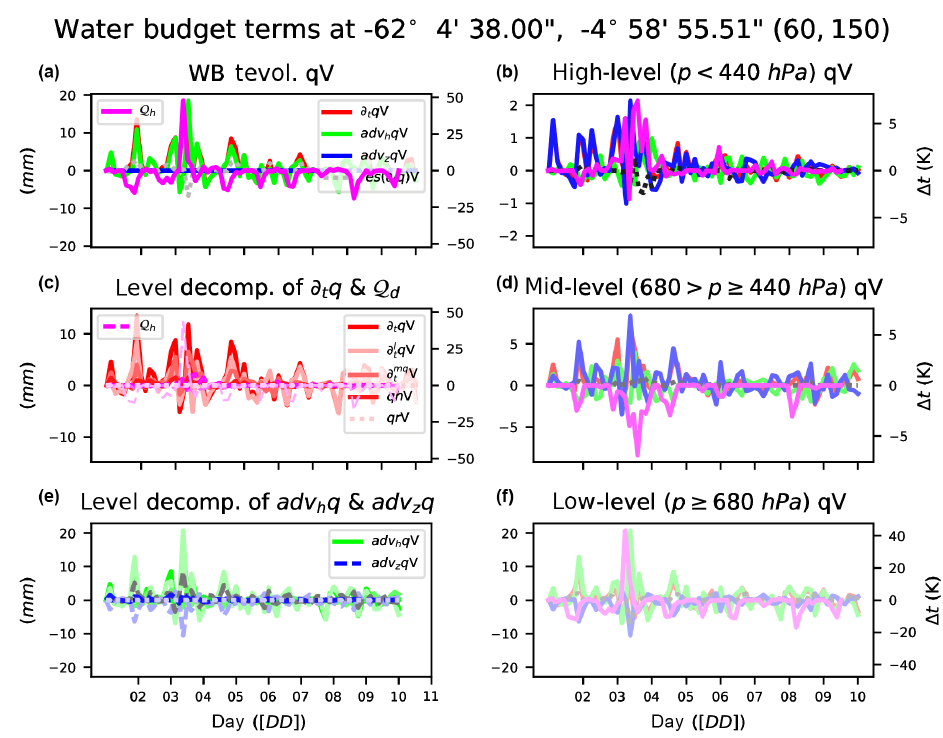
Figure 12. Water budget evolution at a given point for water vapor of vertically integrated water budget terms: total tendency PW ( ∂ t qv, red), horizontal advection F (adv h qv, green), vertical advection Z (adv z qv, green), residual PW– F – Z (res( ∂ t qv), gray dashed), and diabatic heating from microphysics ( Q d , pink) (a) . Only high-level vertically integrated values ( p < 440hPa, b ), high-, mid-, and low-level (degree of color intensity) decomposition of ∂ t qv (red) and Q d (pink) and their respective residuals as dashed lines (c) . Only mid-level vertically integrated values (680 > p ≤ 440hPa, d ), high-, mid-, and low-level (degree of color intensity) decomposition of adv h qv (green) and adv z qv (blue) and their respective residuals as dashed lines (e) , and only low-level vertically integrated values ( p ≥ 680hPa, f